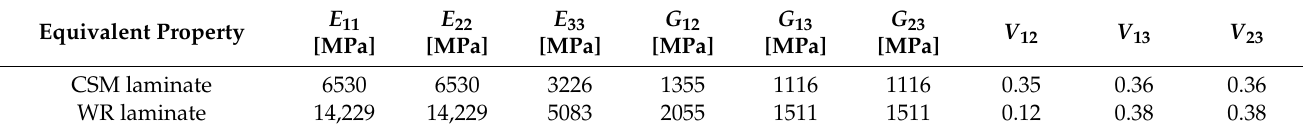
Table 5. Mean macro-scale elastic properties of CSM and WR laminates.